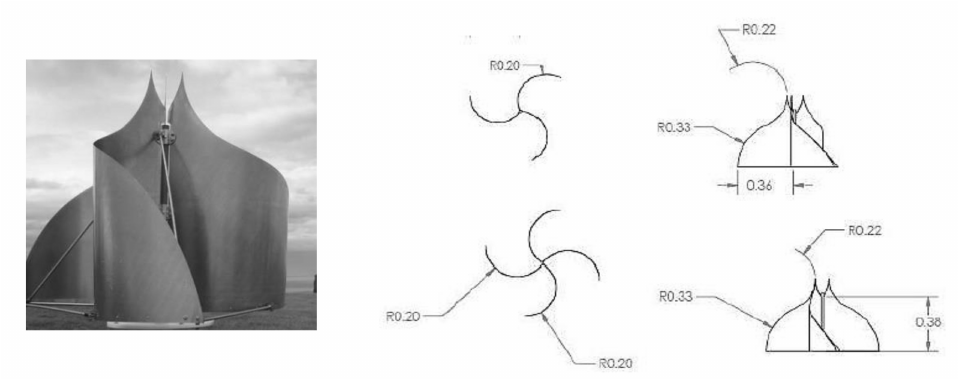
Figure 17. The Ice Wind rotor assembly and geometry for three and four blades [87,88].